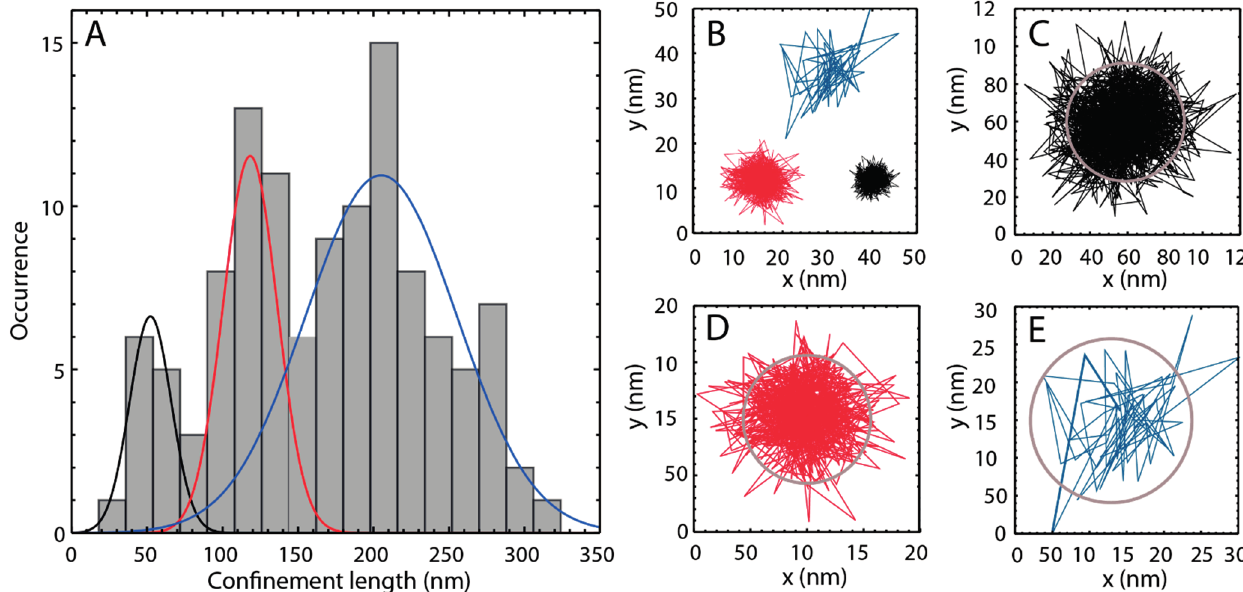
Figure 6. ( A ) Histogram of confinement lengths. The fit represents a multi-Gaussian probability distribution with three subpopulations (subpopulation 1—black line, subpopulation 2—red line, subpopulation 3—blue line); ( B ) Three ATTO-Oxa12 traces, each representative for one of the three subpopulations shown in ( A ). The color of the trace matches the color of the respective subpopulation; ( C – E ) Individual ATTO-Oxa12 traces with confinement lengths of 63 ± 3 nm ( C ), 113 ± 5 nm ( D ), and 220 ± 20 nm ( E ). The circular confinements are indicated by gray